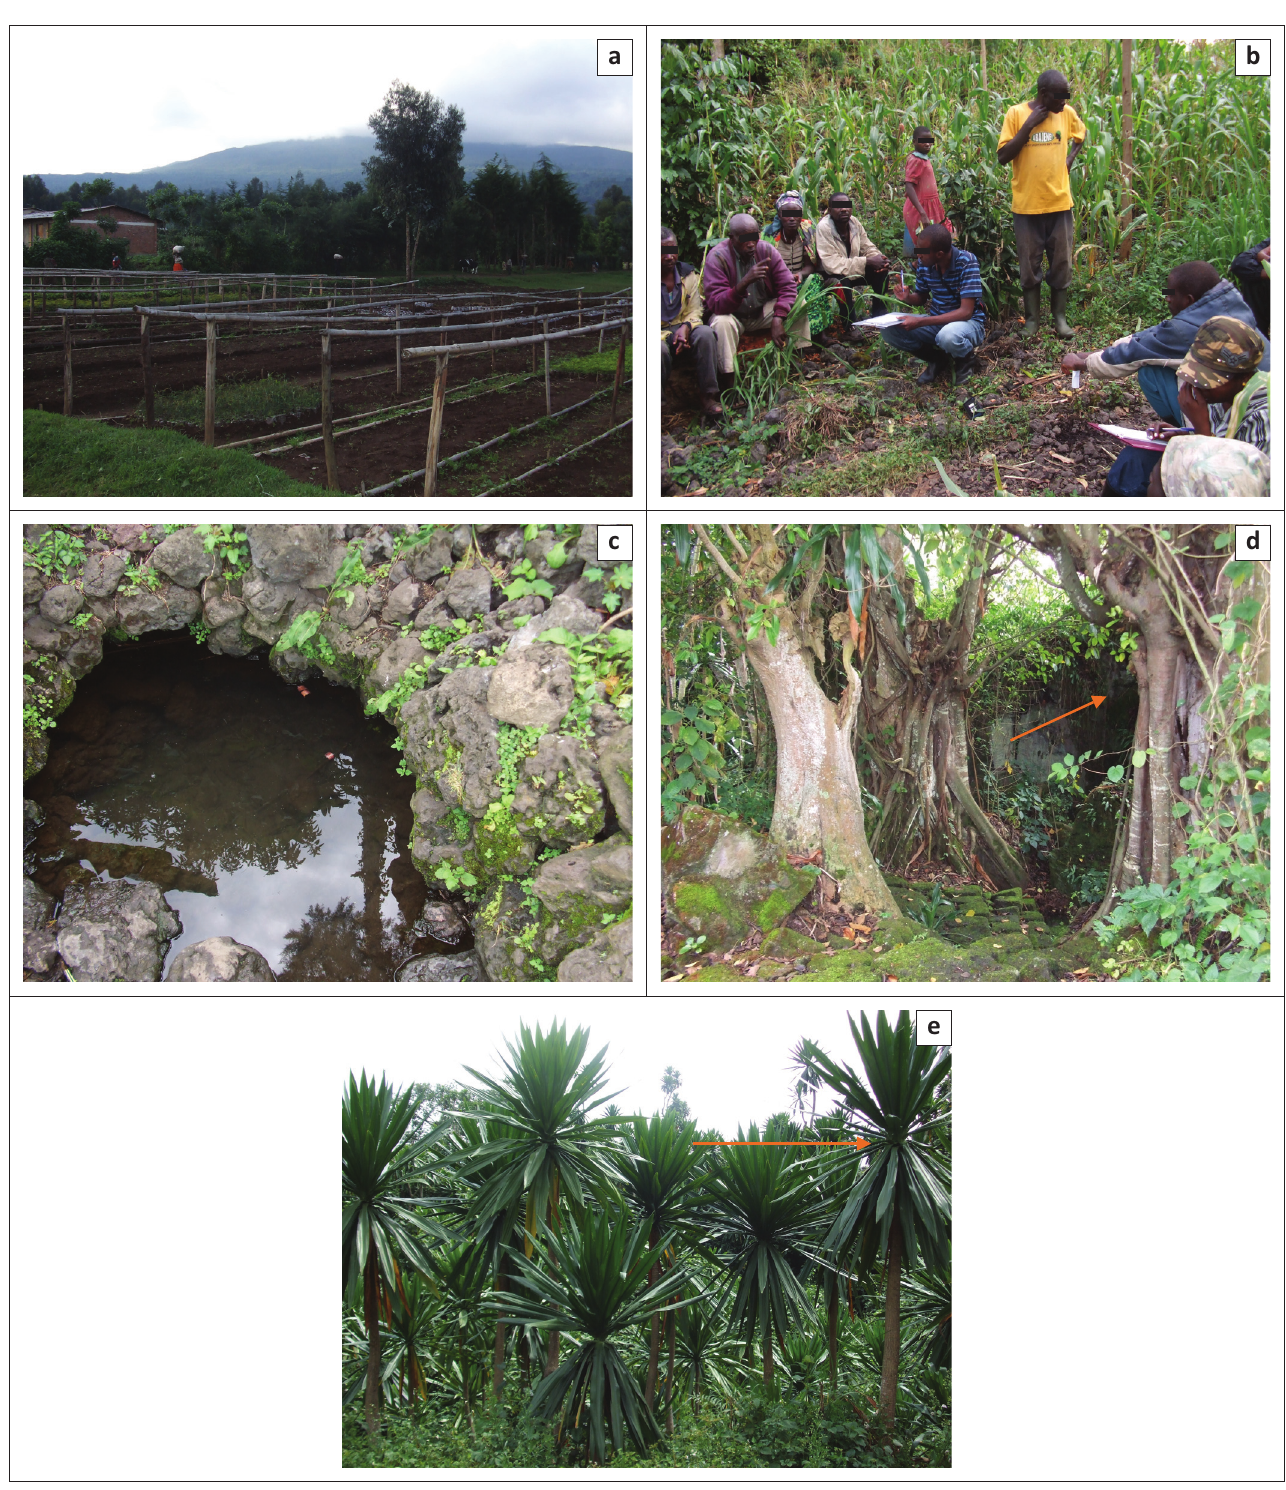
FIGURE 1-A1: (a) Photo showing the village surrounding the study area, (b) one of the group discussion with local indigenous, (c) and some important sites and species of Buhanga sacred forest including the mysterious water-spring, (d) cave (e) and Dracaena steudneri